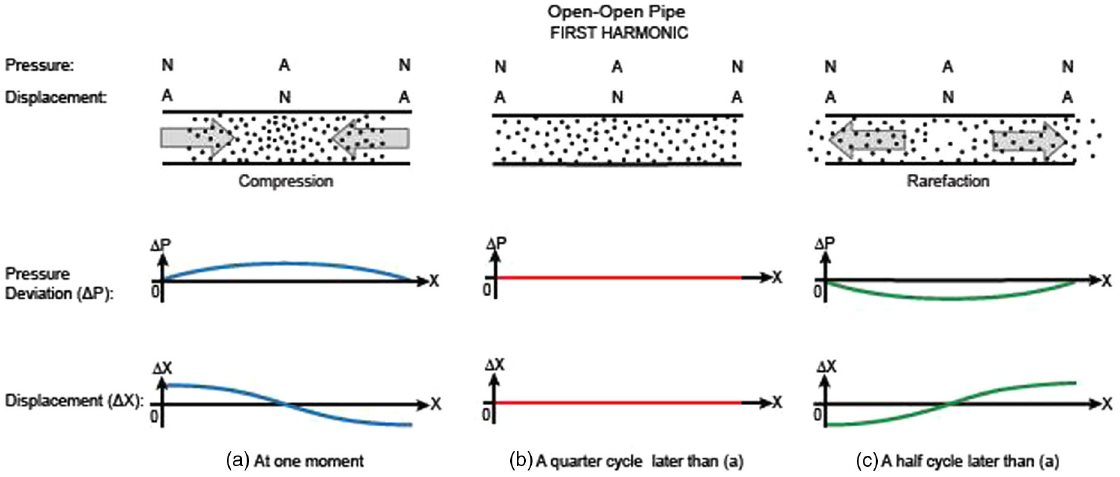
FIG. 9. First harmonic standing sound wave in an open-open